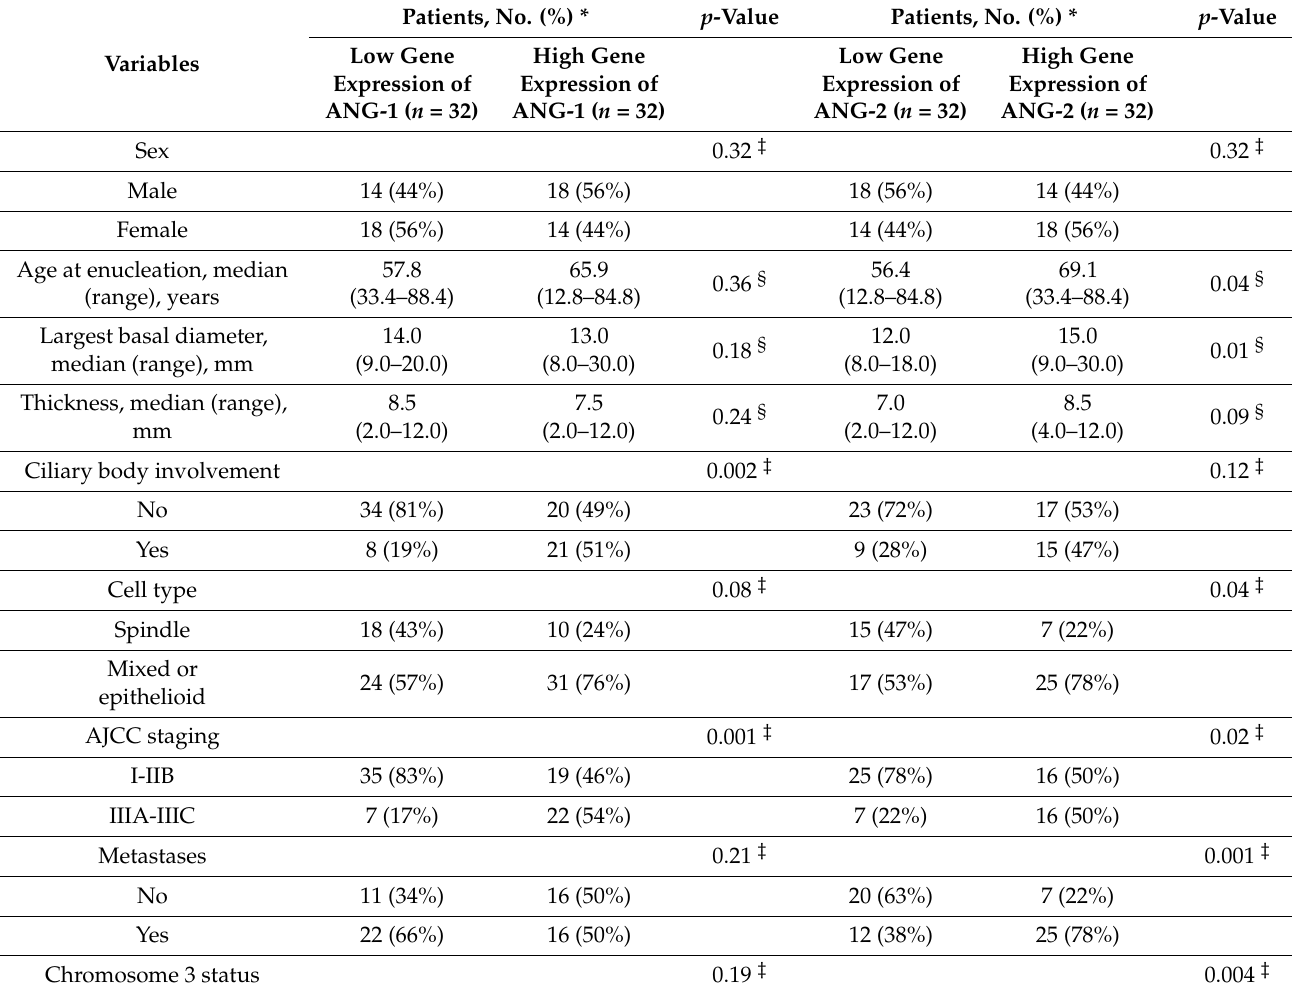
Table 1. Comparison of clinical, histopathological, and genetic characteristics of UM with a low or high mRNA gene expression of ANG-1 and ANG-2. The groups were separated according to the median. Patients, No. (%) Variables